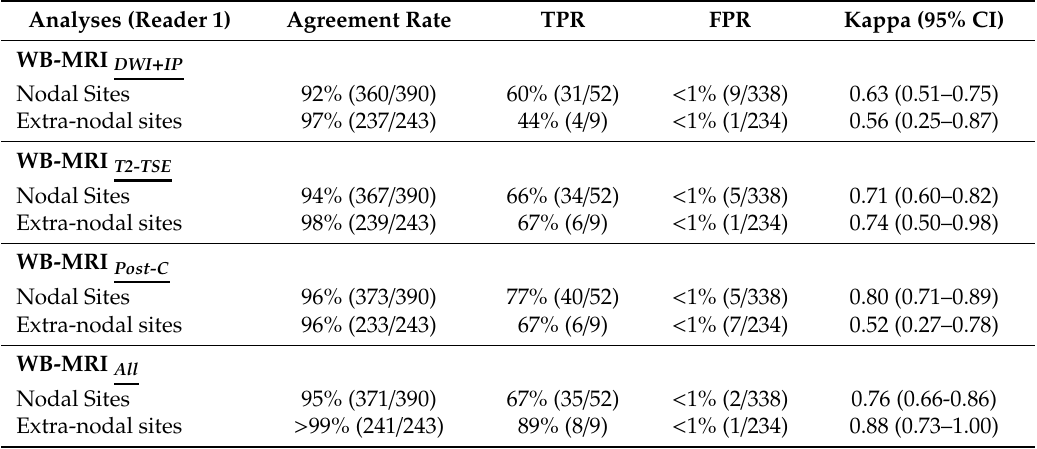
Table 3. Comparison of different MRI sequences as part of the WB-MRI protocol for nodal and extra-nodal disease evaluation for reader 1.